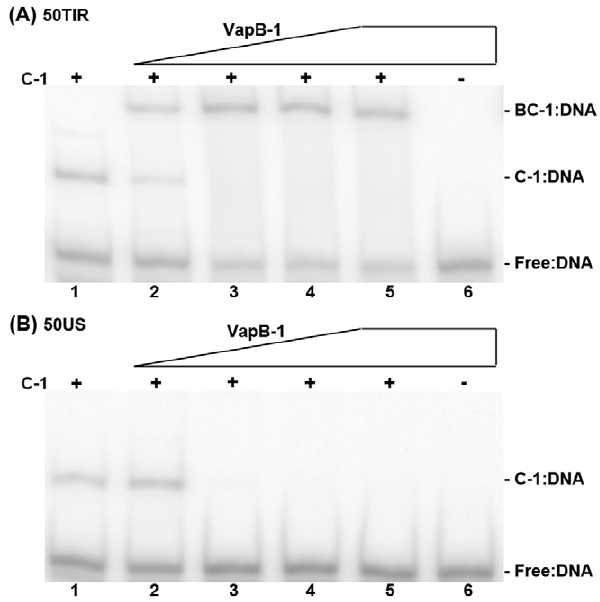
Figure 8. VapB-1 targets VapC-1 to the vapB-1 translation initiation region. Gel shift products from a titration of VapB-1 into samples following VapC-1 binding to (A) 50TIR or (B) 50US at a 100:1 molar ratio of protein to DNA. The gels show the products of the following samples: VapC-1 and DNA without VapB-1 ( lane 1 ), the addition of Vap B-1 at a 50, 100, 200 or 300 molar ratio with the DNA substrate ( lanes 2–5 ), and VapB-1 only at a 300:1 protein to DNA ratio ( lane 6 ). The identity of each band is noted at the right of each gel. Each